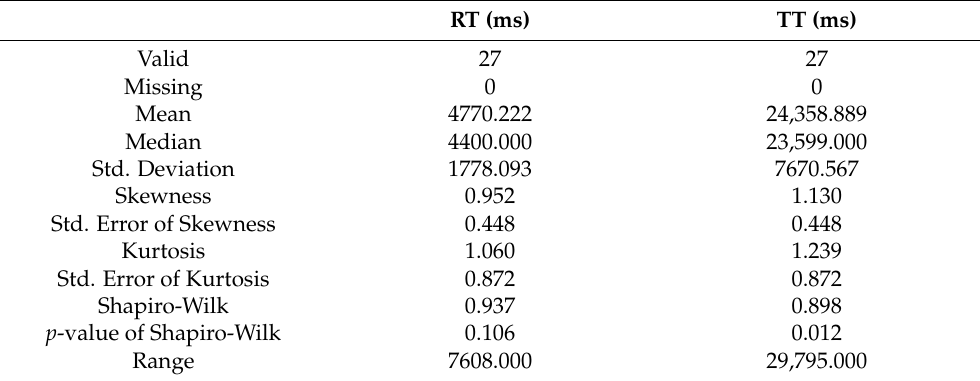
Table A1. Descriptive statistics with normality tests for reaction time (RT) (ms) and Total Time (TT) (ms) for the tutorial.